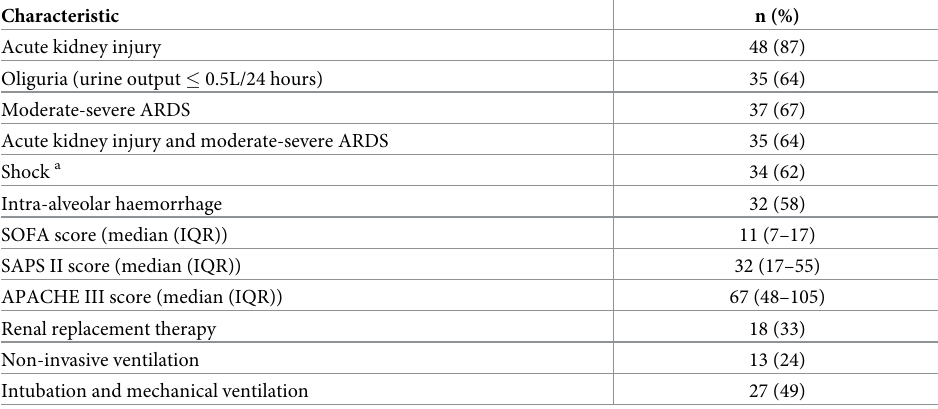
Table 4. Manifestations of severe leptospirosis and need for organ support in Far North Queensland, Australia between 1997 and 2018. Characteristic n (%)